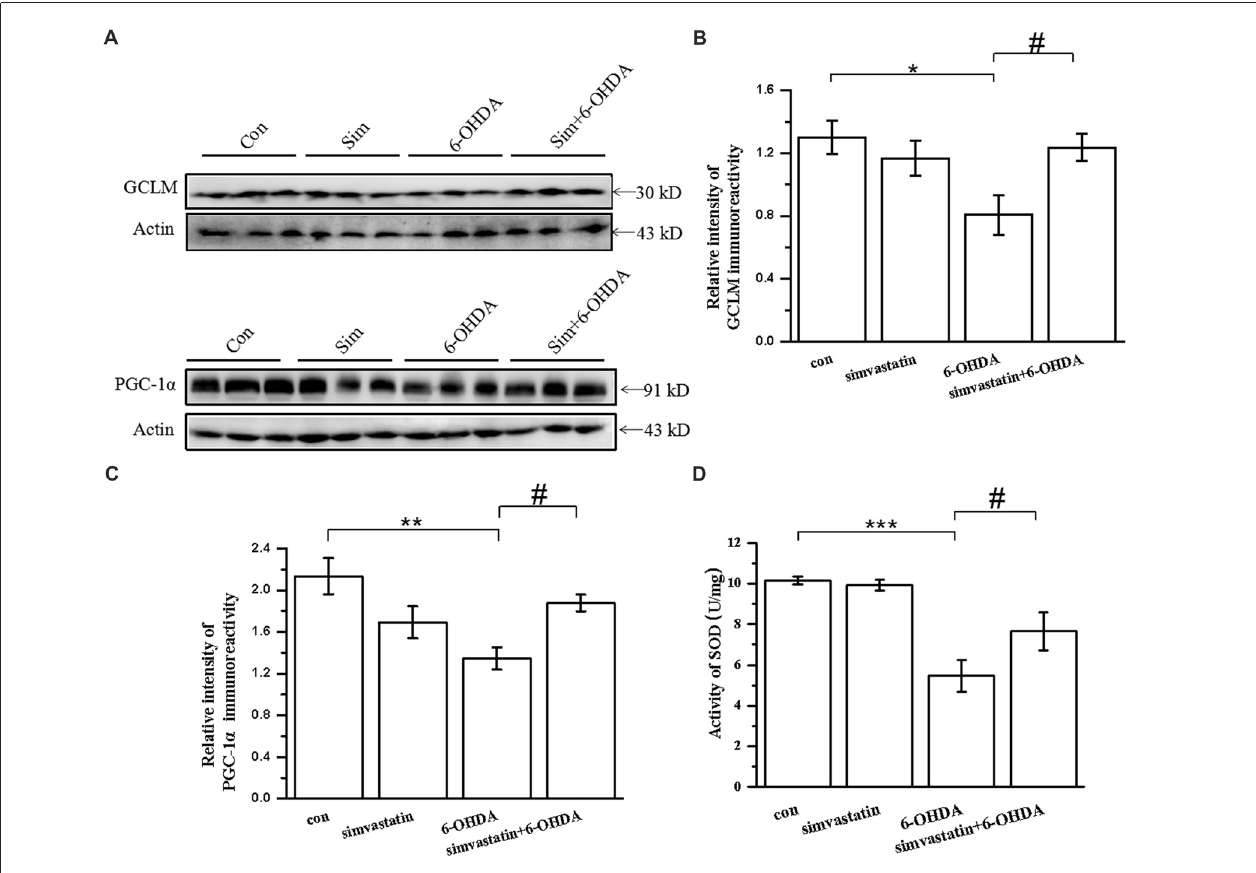
FIGURE 9 | Simvastatin enhanced expression of anti-oxidative signaling molecules in midbrain samples in the unilaterally 6-OHDA-lesioned mouse model of PD. (A) Total protein in the midbrain was extracted with RIPA buffer, then western blot was used to detect the expression of GCLM and PGC-1 α . Relative quantitative analysis of GCLM (B) and PGC-1 α (C) expression performed using ImageJ. (D) Total SOD activity of midbrain samples determined using a Beyotime Total SOD Assay Kit; data were obtained from three independent experiments. Statistical analysis by Dunnett’s T3 or LSD post hoc test based on ANOVA; data expressed